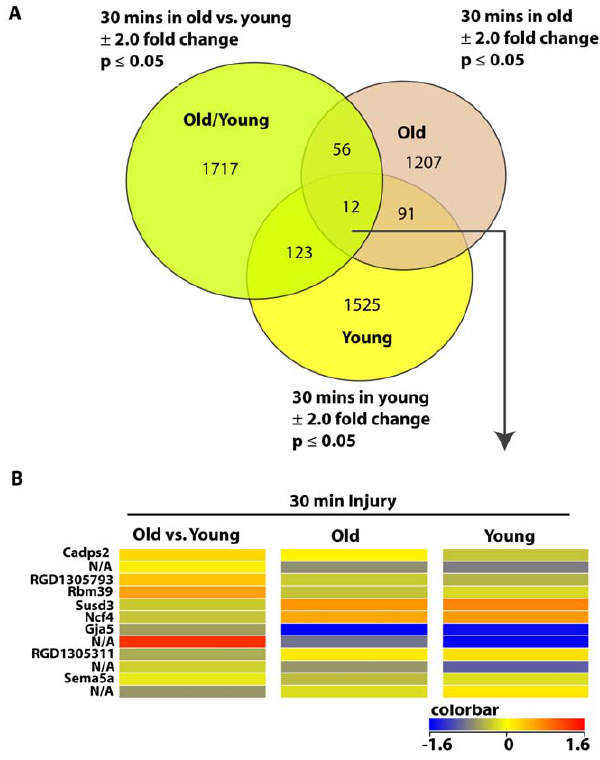
Figure 2. Differentially expressed genes overlapping in different age groups of 30 min-injured rat iliac arteries. A. Venn diagram shows lists of differentially expressed genes determined by our analysis of 3 different pairs of age groups of 30 min-injured rat iliac arteries. Gene lists were compared to find common differentially expressed transcripts. A 2.0 fold change and p , .05 significance cut-offs were used. No multiple correction was employed. B. Heat map of differentially expressed genes overlapping in different age groups of 30 min-injured rat iliac arteries.12 genes overlapped in old versus young, old versus old, and young versus young, 30 min-injured rat iliac arteries. Color bar shown in Log 2 .